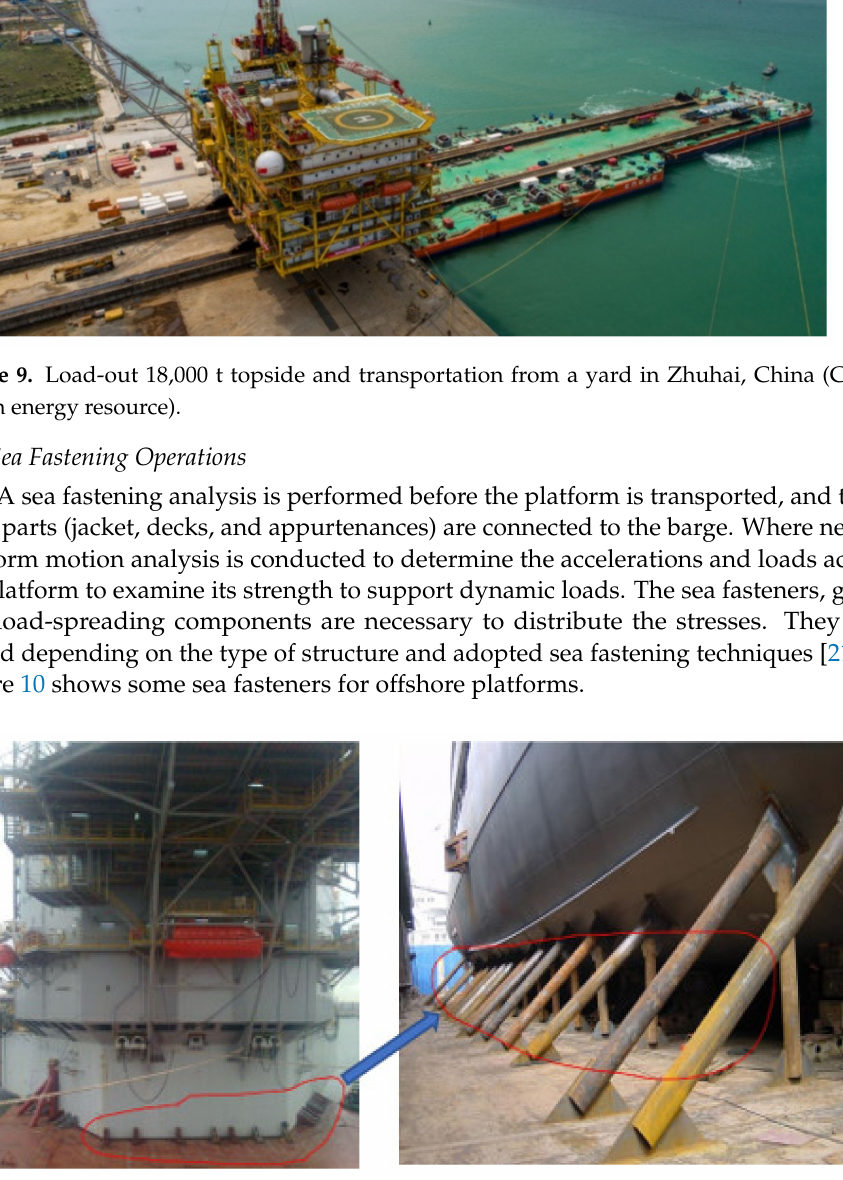
Figure 10. Sea fasteners for offshore platforms, showing the front and zoomed-out